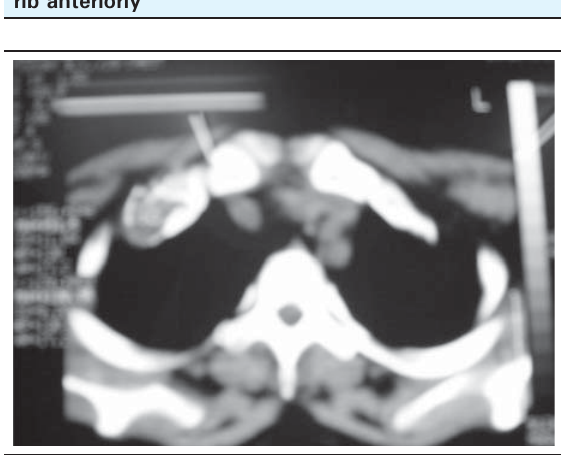
Figure 3. CT scan chest showing mass arising from anterior arc of 1 st